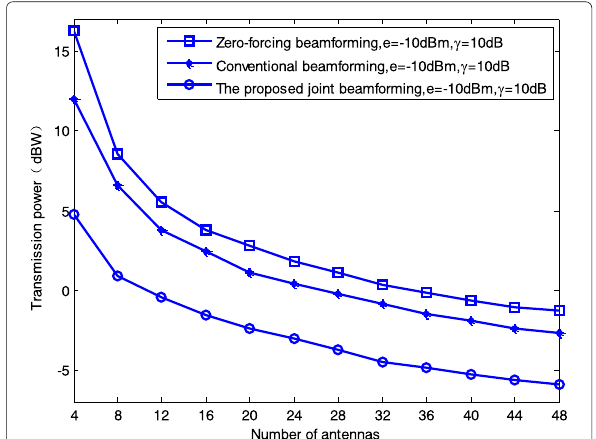
Fig.7 The relation between transmission power and antenna